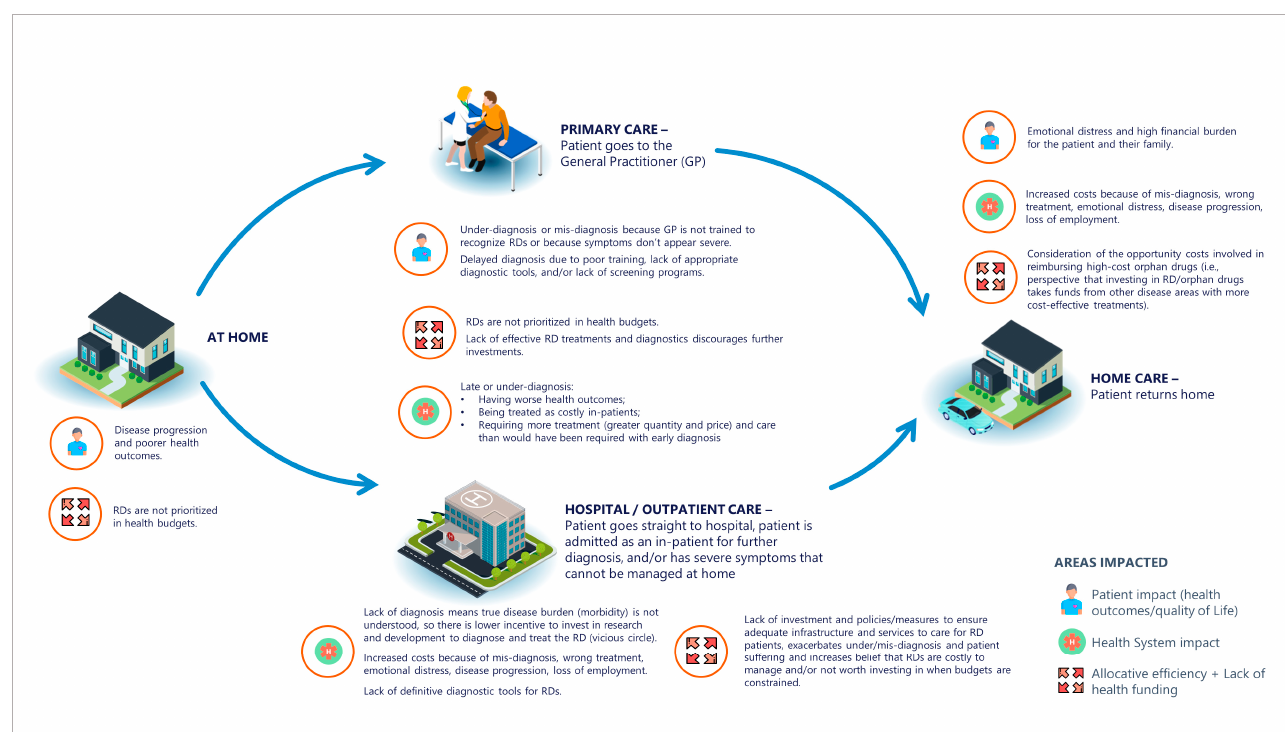
Figure 2. Challenges along the RD patient journey. Source: Elaborated by authors.